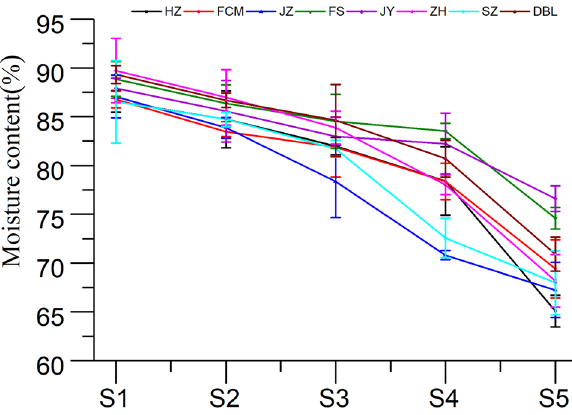
Figure 2. Change in moisture content of jujube fruit at various developmental